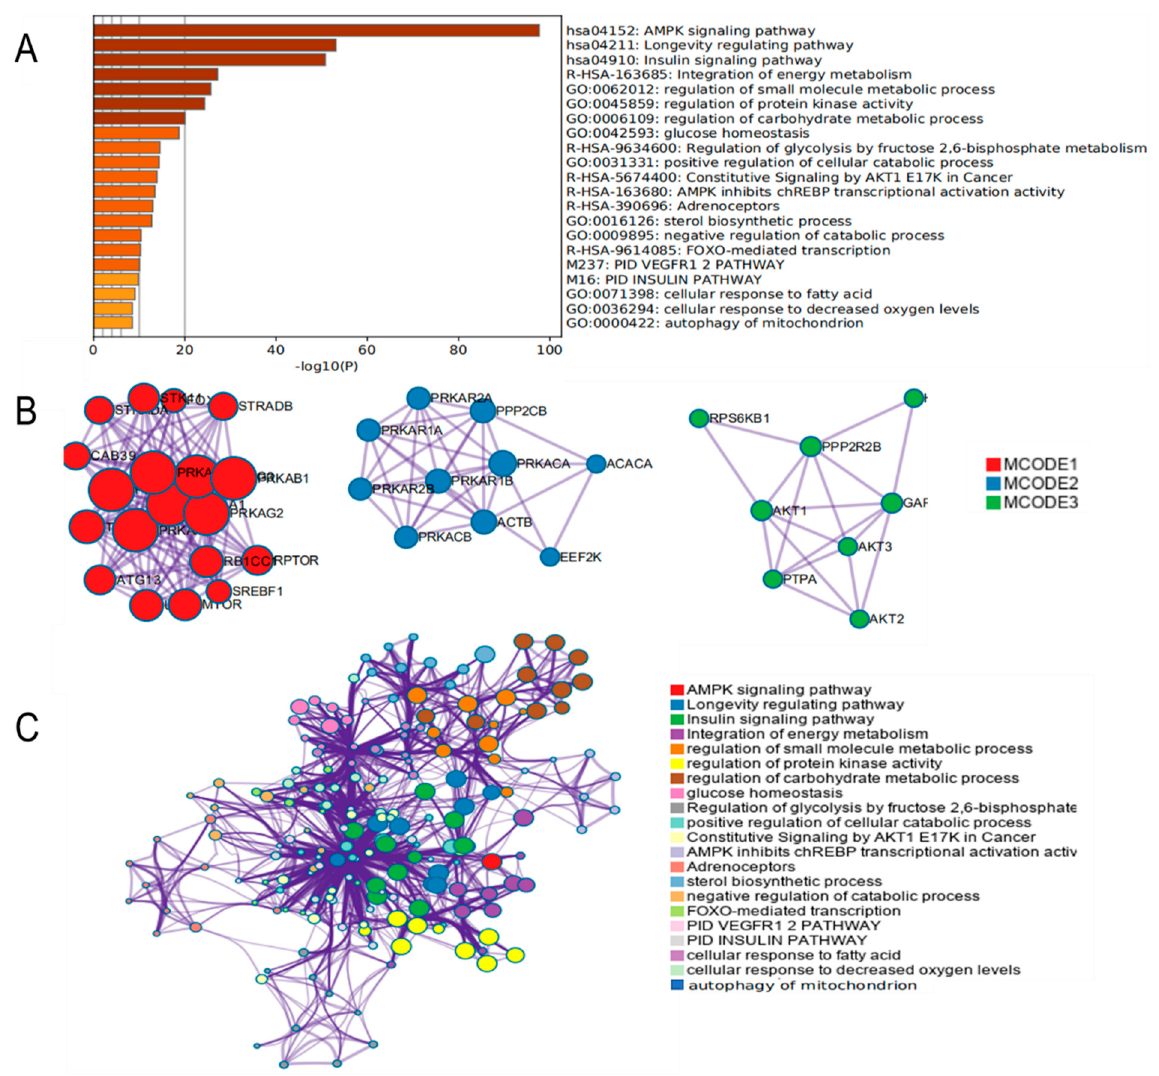
Figure 4. Functional enrichment analysis and protein interactions analysis of AMPK signaling pathway using Metascape. ( A ) Histogram of gene functional enrichment analysis. ( B ) Protein interaction analysis graph. ( C ) Network diagram of gene functional enrichment analysis.